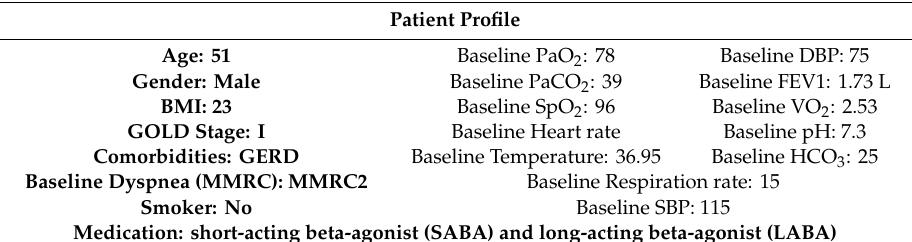
Table 7. Profile of the patient.